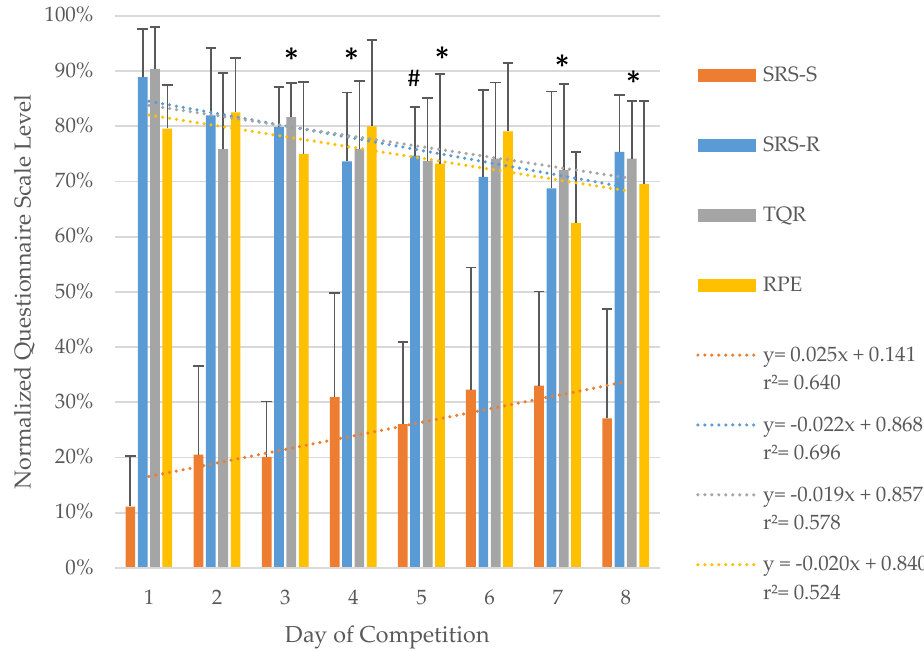
Figure 2. Daily di ff erences for SRS-S, SRS-R, TQR, and RPE over the course of competition. Results are Figure 2. Daily differences for SRS-S, SRS-R, TQR, and RPE over the course of competition. Results presented as mean ± SD (95% CI) of normalized questionnaires scale level; # —Significant di ff erence for are presented as mean ± SD (95% CI) of normalized questionnaires scale level; # — Significant SRS-R to 1st day of competition; *—Significant di ff erence for TQR to 1st day of difference for SRS-R to 1st day of competition; * — Significant difference for TQR to 1st day of competition.